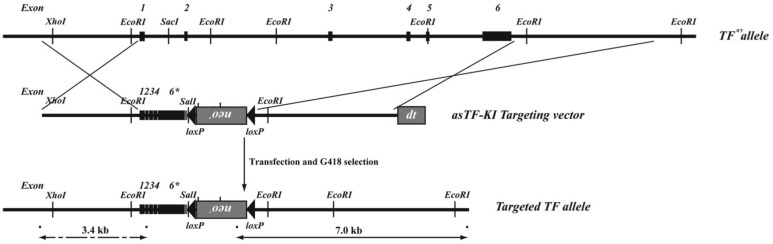
Targeting of the TF gene.The murine TF allele was targeted with a replacement-type vector containing the murine asTF open reading frame flanked by 3 kb 5′ and 5.2 kb 3′ homology arms. Diphtheria toxin (dt) was used for negative selection. After homologous recombination into 129P2/OlaHsd embryonic stem cells, a loxP flanked neomycin resistance cassette was removed by transfection with a Cre expression plasmid.